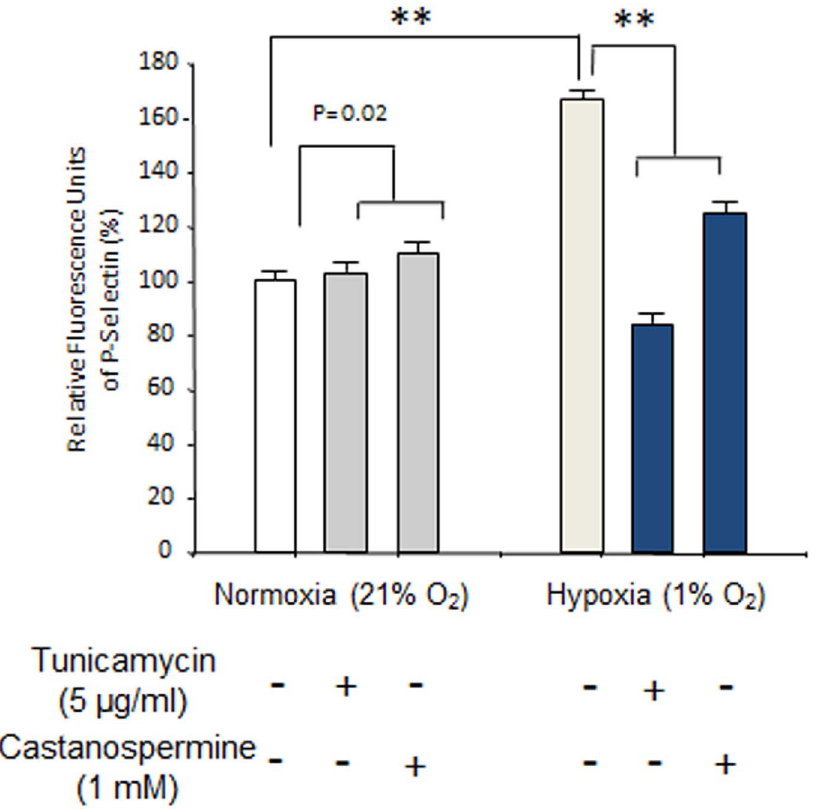
Figure 6. Effect of glycosylation inhibitors on hypoxia-induced leukocyte adhesion to HUVECs. Leukocytes were isolated from SCD model mice. HUVECs pretreated with glycosylation inhibitors were exposed to normoxia (21% O 2 ) or hypoxia (1% O 2 ). The adhesion levels of leukocytes to HUVECs at normoxia was set to 100%. Data are mean 6 SEM; n=3 to 5. **, p , 0.0001.